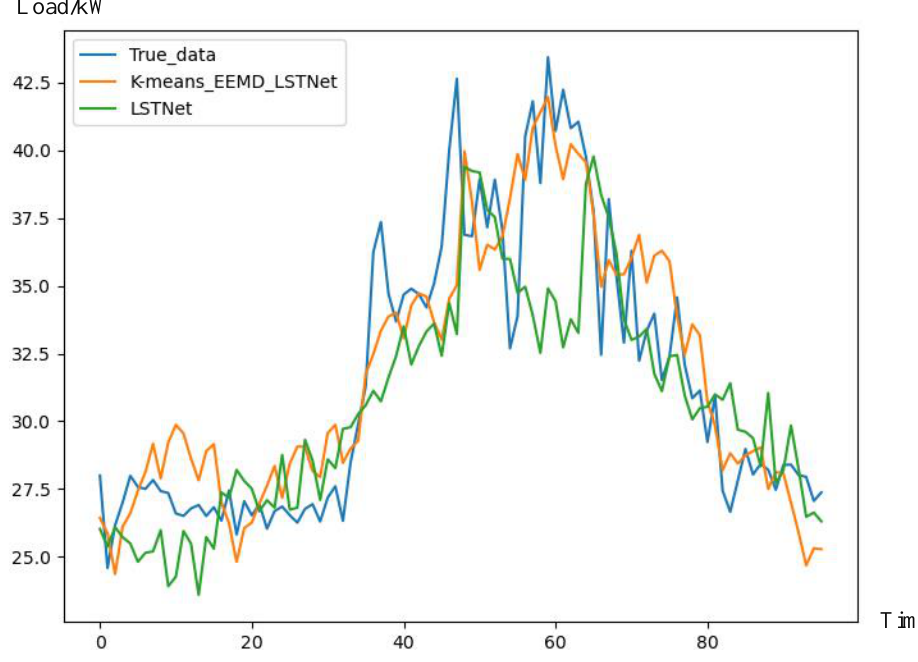
Figure 8. Comparison of predicted results for LSTNet and K-means-EEMD-LSTNet load forecast- ing models.